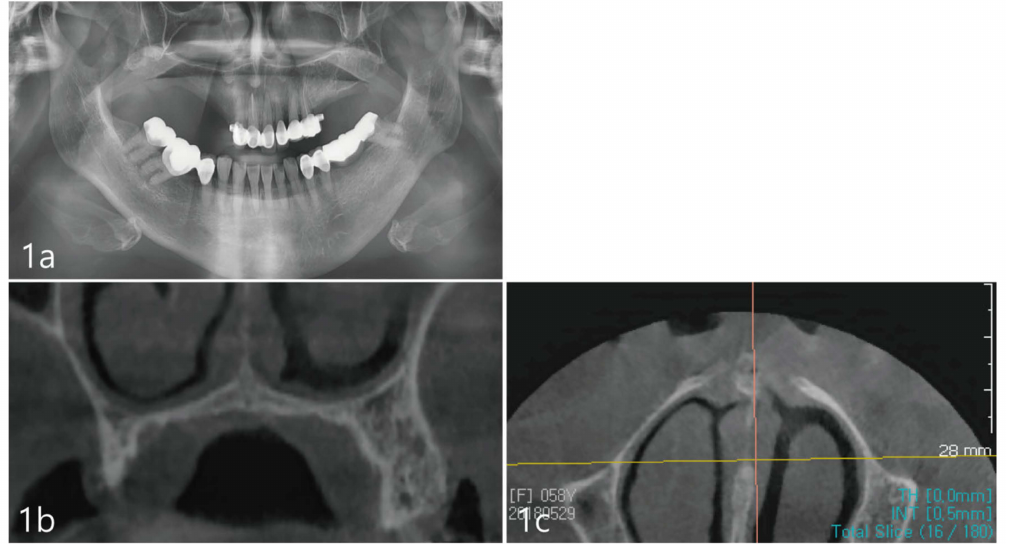
Figure 1. ( a ). Pre-operative panoramic radiograph shows severely atrophic posterior maxilla. The maxillary sinus is not well-observed. ( b ). Coronal view of the CBCT showing a portion of the